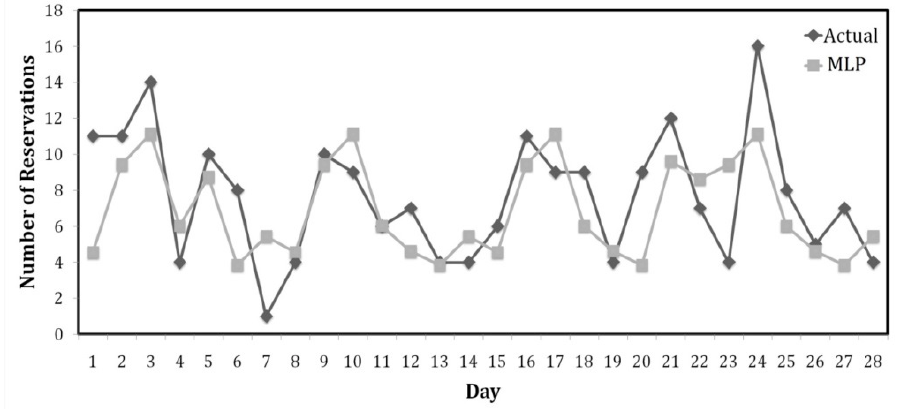
Figure 4. Predicted total number of reservations using MLP (multilayer perceptron) in the Seongbuk-gu area.